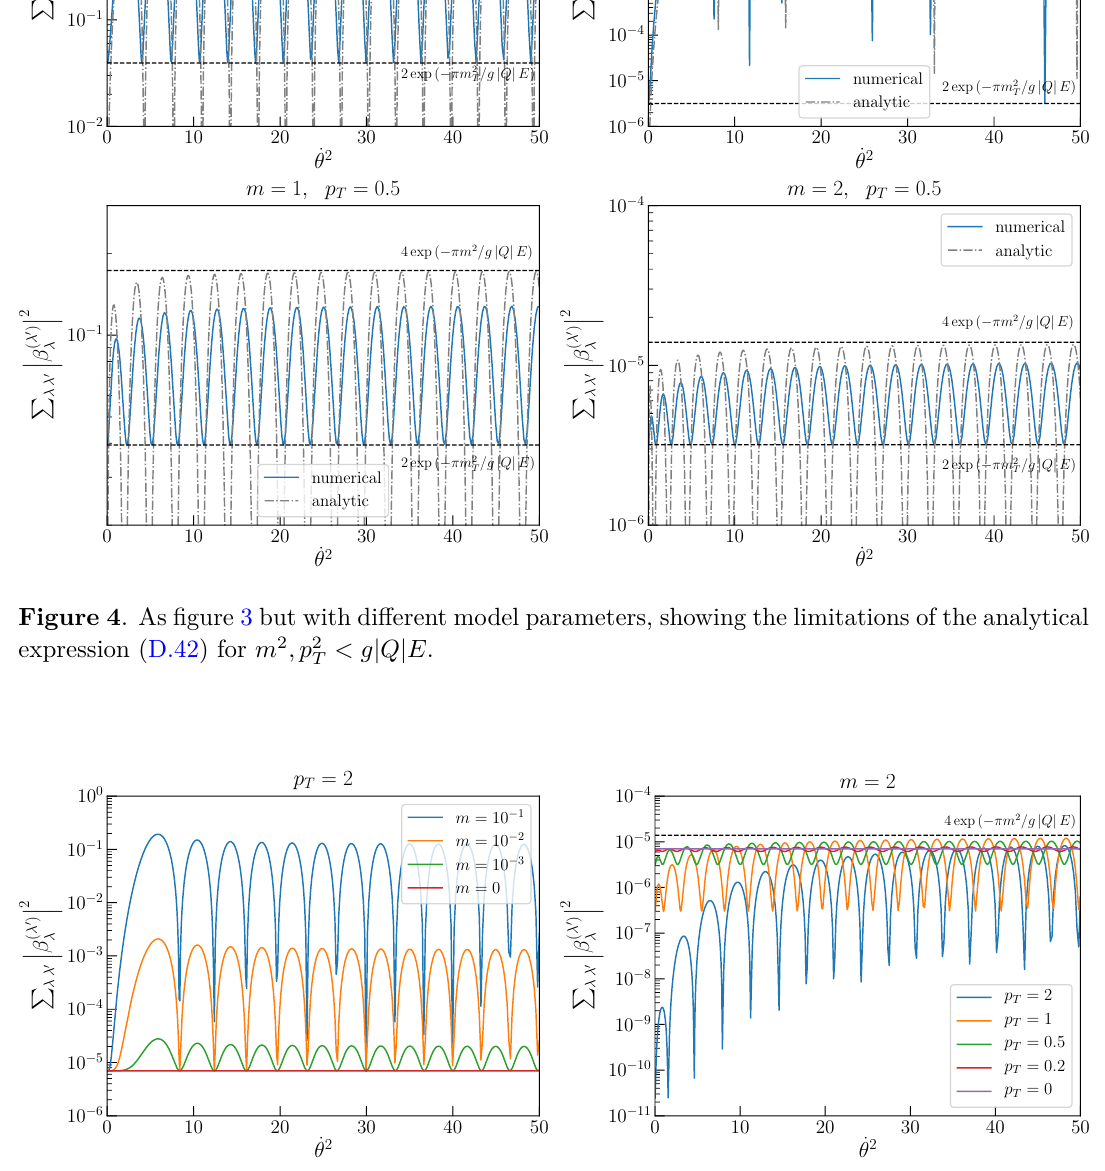
Figure 5 . The height of the plateau of the spectrum of P a function of ˙ θ for small values of m (left) and p T (right). The parameters are shown in the unit g | Q | E = 1